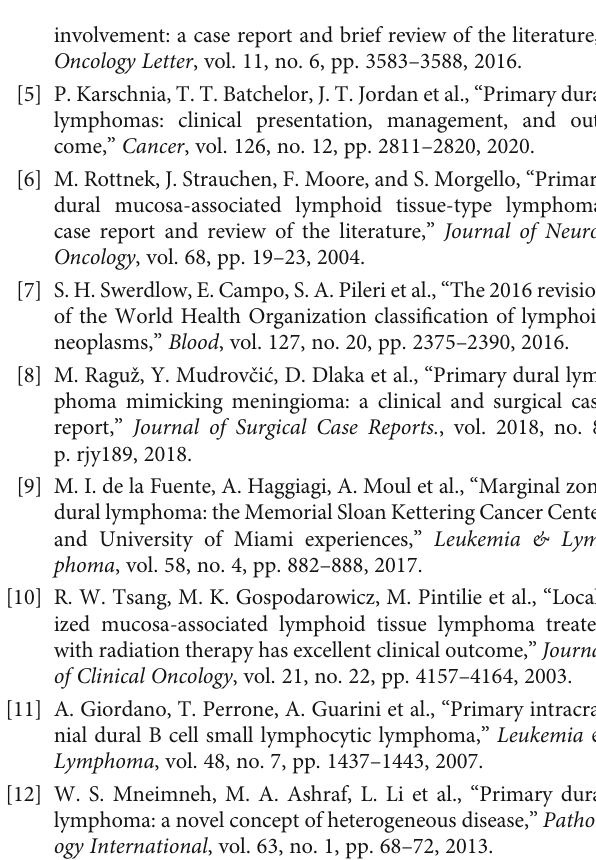
Figure 3: (a) Routine H&E stain demonstrates the atypical lymphocytes. These lymphocytes are positive for CD20 (b) with increased Ki-67 proliferation index